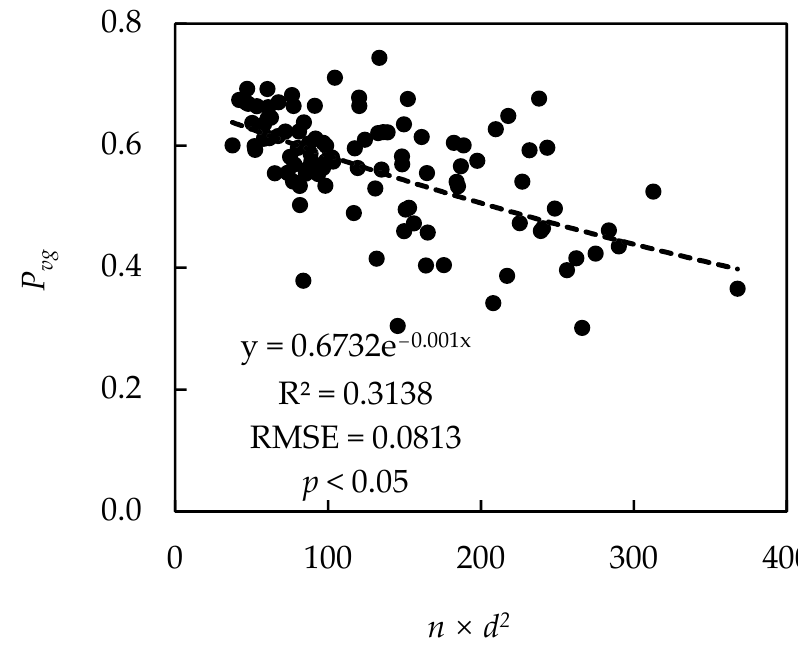
Figure 5. Scattering plot between P vg and n × d 2 .